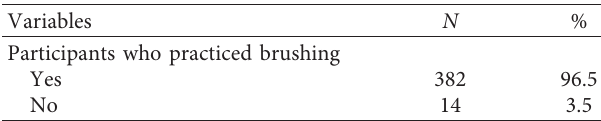
Table 2: Distribution of the sample size according to the number of participants who practiced brushing.